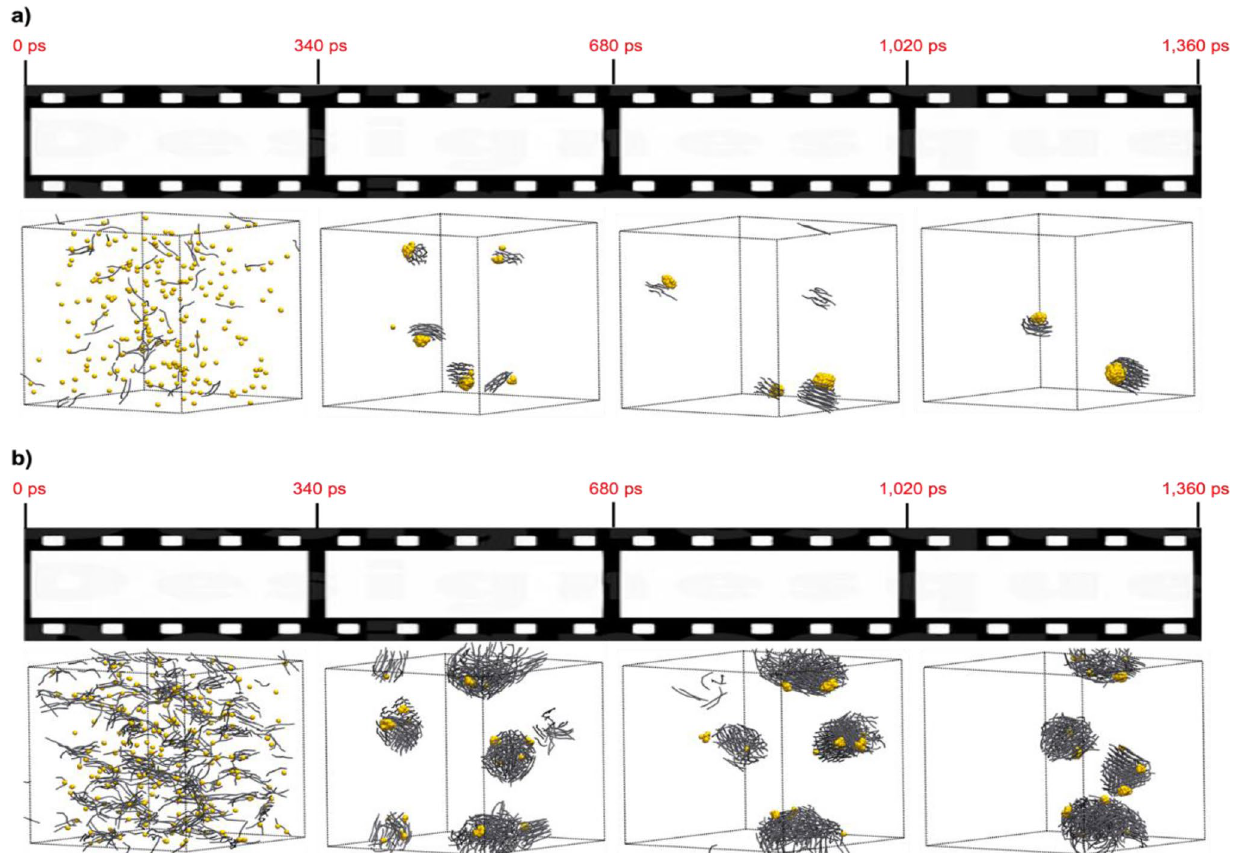
Figure 5. ( a ) 333 gold beads are mixed with 55 C-type surfactants. ( b ) 333 gold beads mixed with 500 C-type molecules. Water molecules are removed for clarity. All compounds are randomly distributed in a cubic box of 30 × 30 × 30 d 0 3 . Gold beads are represented using CPK model of VMD while C-type molecules are shown in Licore